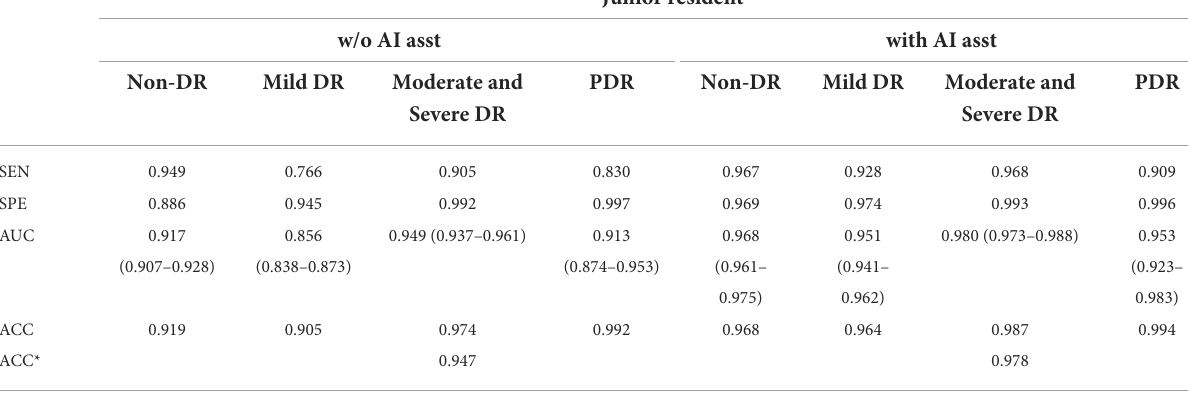
TABLE 4 Manual detection of diabetic retinopathy based on ICDR grading system by the junior resident.